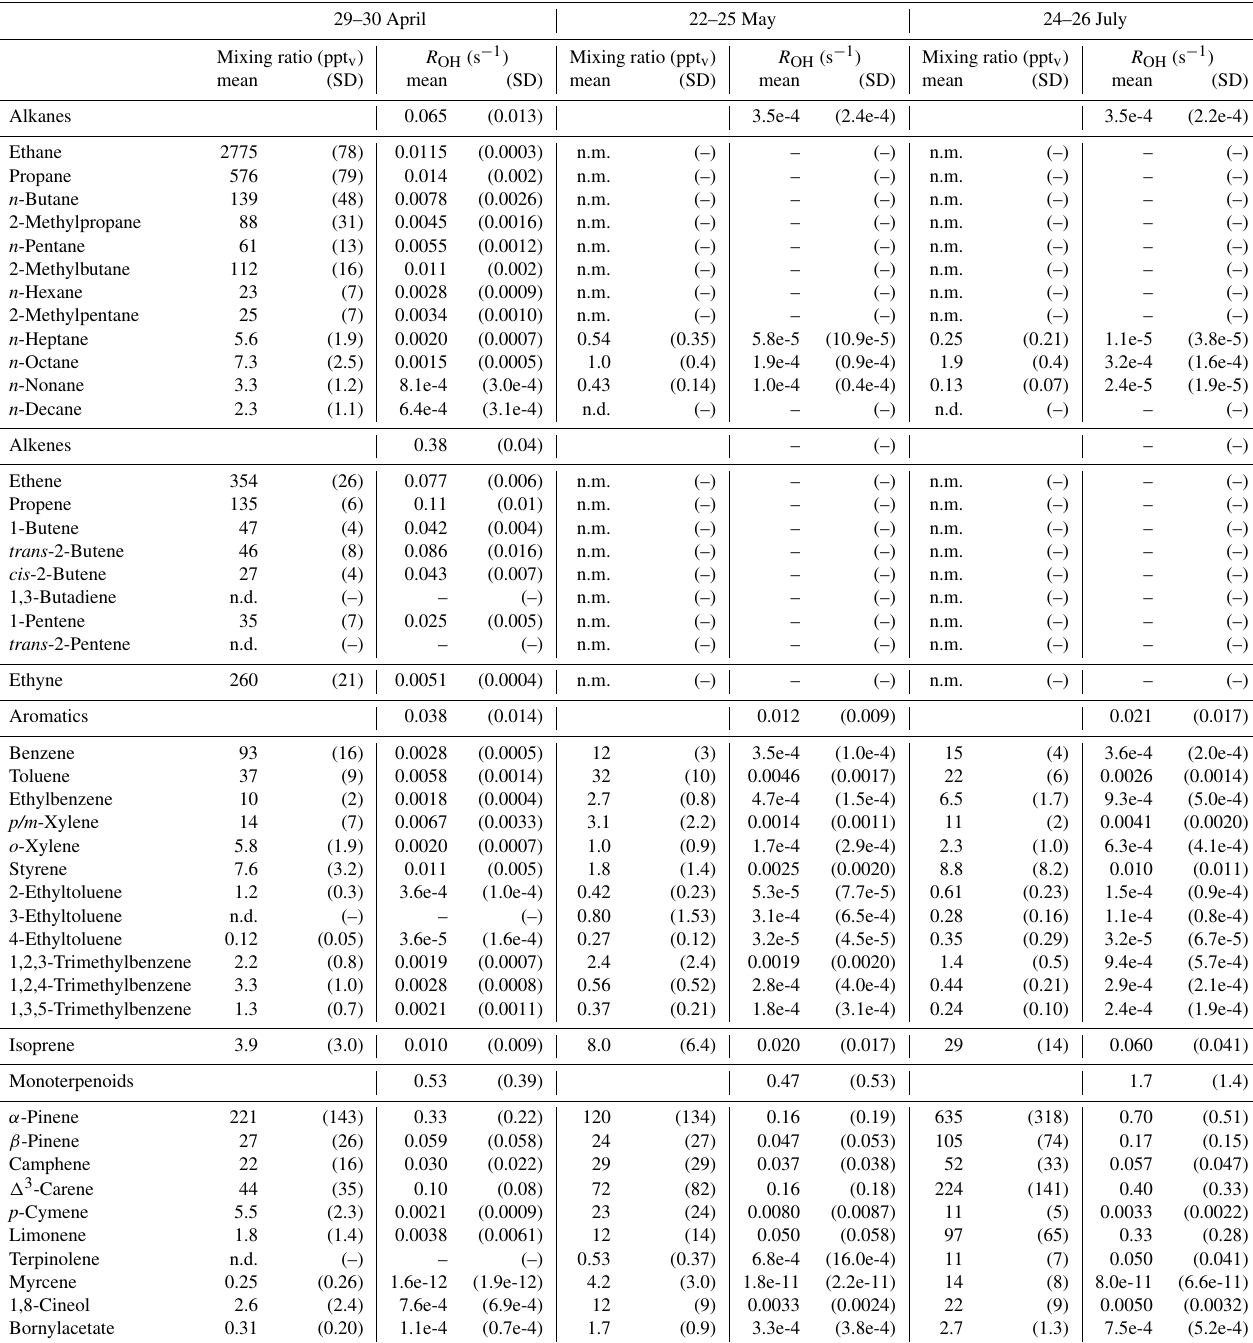
Table D1. Averages of individual compound mixing ratios (ppt v ) and calculated OH reactivity, R OH (s − 1 ), and group R OH for the three periods studied with SOSAA. “n.d.” means “not detected” and “n.m.” means “not